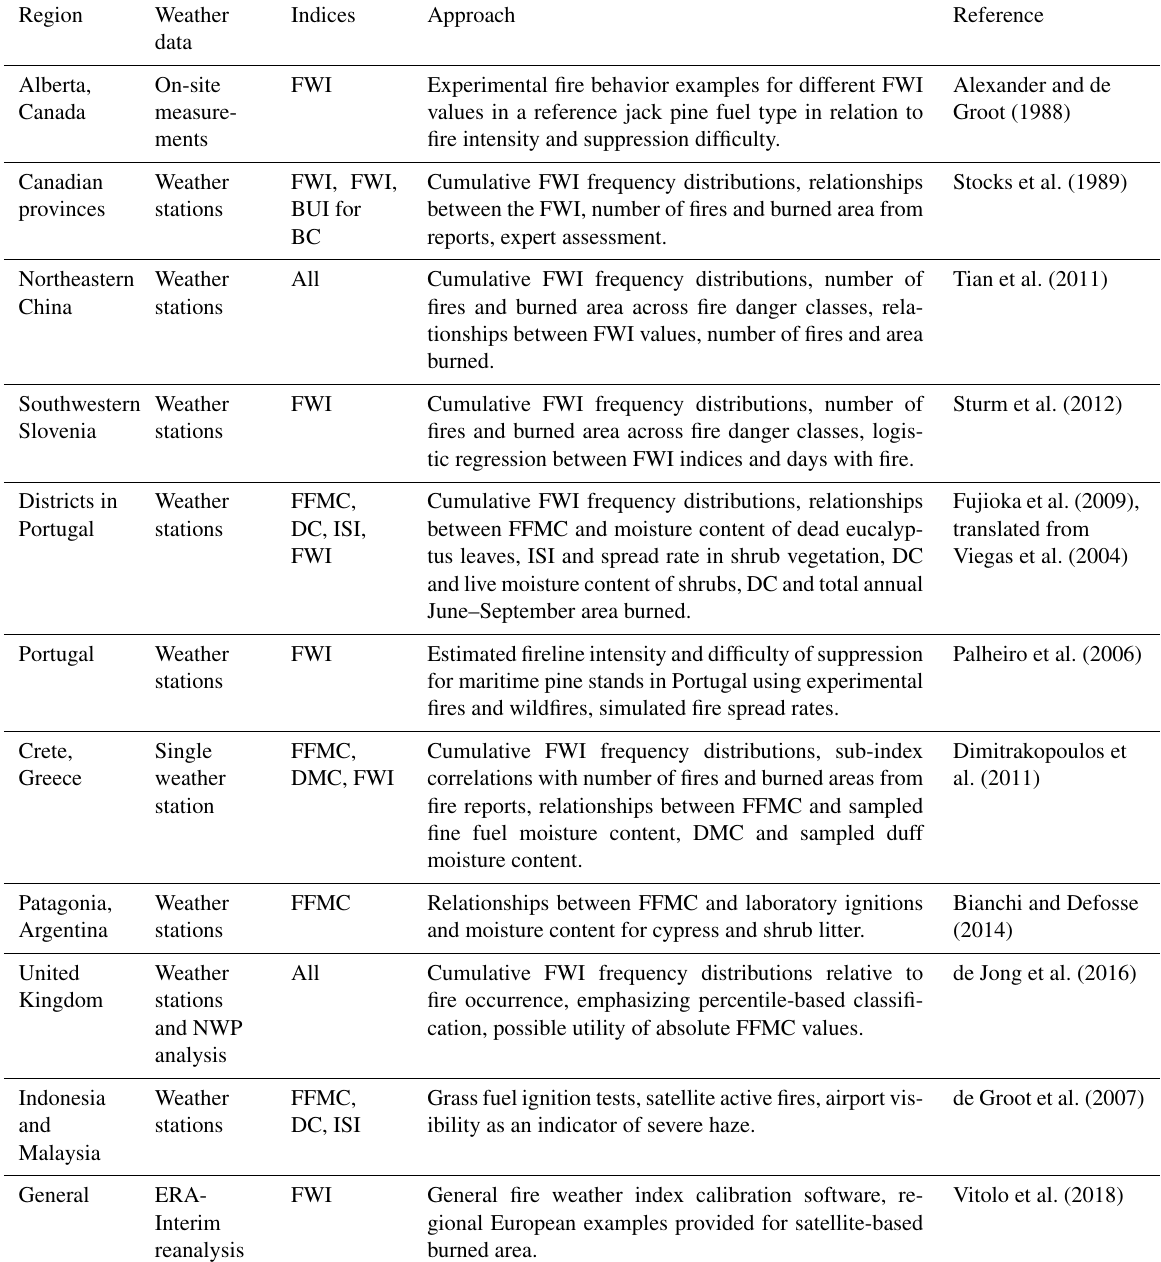
Table 1. Examples of FWI calibration and adaptation studies for different fire environments around the world. Region Indices Approach